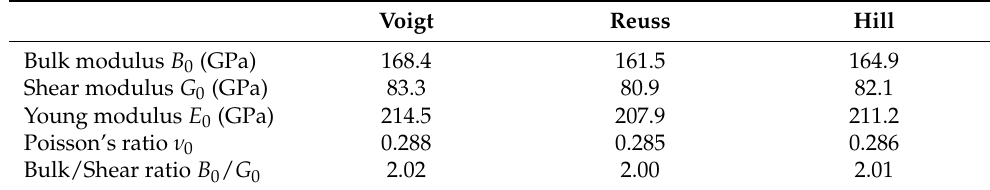
Table 5. Elastic moduli B 0 , E 0 and G 0 ; B 0 / G 0 ratio; and Poisson’s ratio ν 0 , calculated using the Voigt, Reuss, and Hill approximations from the calculated elastic coefficients at 0 GPa of DyScO 3 perovskite.